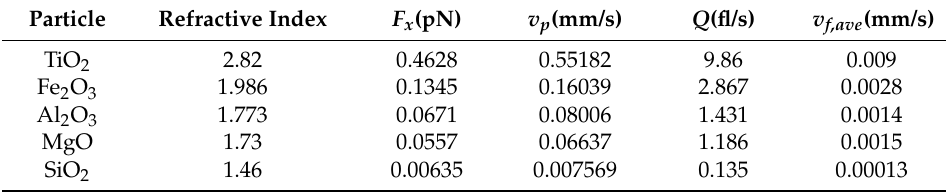
Table 1. Typical axial forces, particle velocities, and volume flowrate transported by